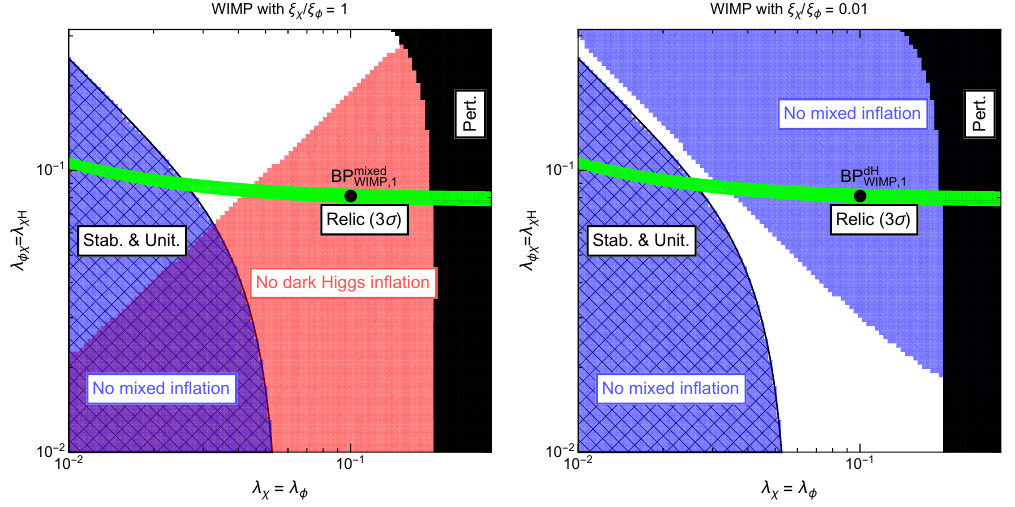
Figure 1 . Parameter space for WIMP dark matter scenario with (cid:24) (cid:31) =(cid:24) (cid:30) = 1 (left) and 0 : 01 (right) for the quartic self-couplings with (cid:21) (cid:31) = (cid:21) (cid:30) versus the quartic mixing couplings with (cid:21) (cid:30)(cid:31) = (cid:21) (cid:31)H . The parameters shown here are set at low-energy scale. The rest input parameters are chosen as (cid:16) = 0 : 05, g X = 0 : 1 ; sin (cid:18) = 0 : 01, " = 10 (cid:0) 4 , m h 0 = 100 GeV and m (cid:31) = 500 GeV. Constraints from dark matter physics and cosmic in(cid:13)ation are shown. The green region represents the correct dark matter relic abundance within 3 (cid:27) range [2]. The hatched and black regions are disfavored due to stability, unitarity and perturbativity. The dark Higgs (mixed) in(cid:13)ation is not allowed in the red-colored (blue-colored) region. The black points are our benchmark points shown in table